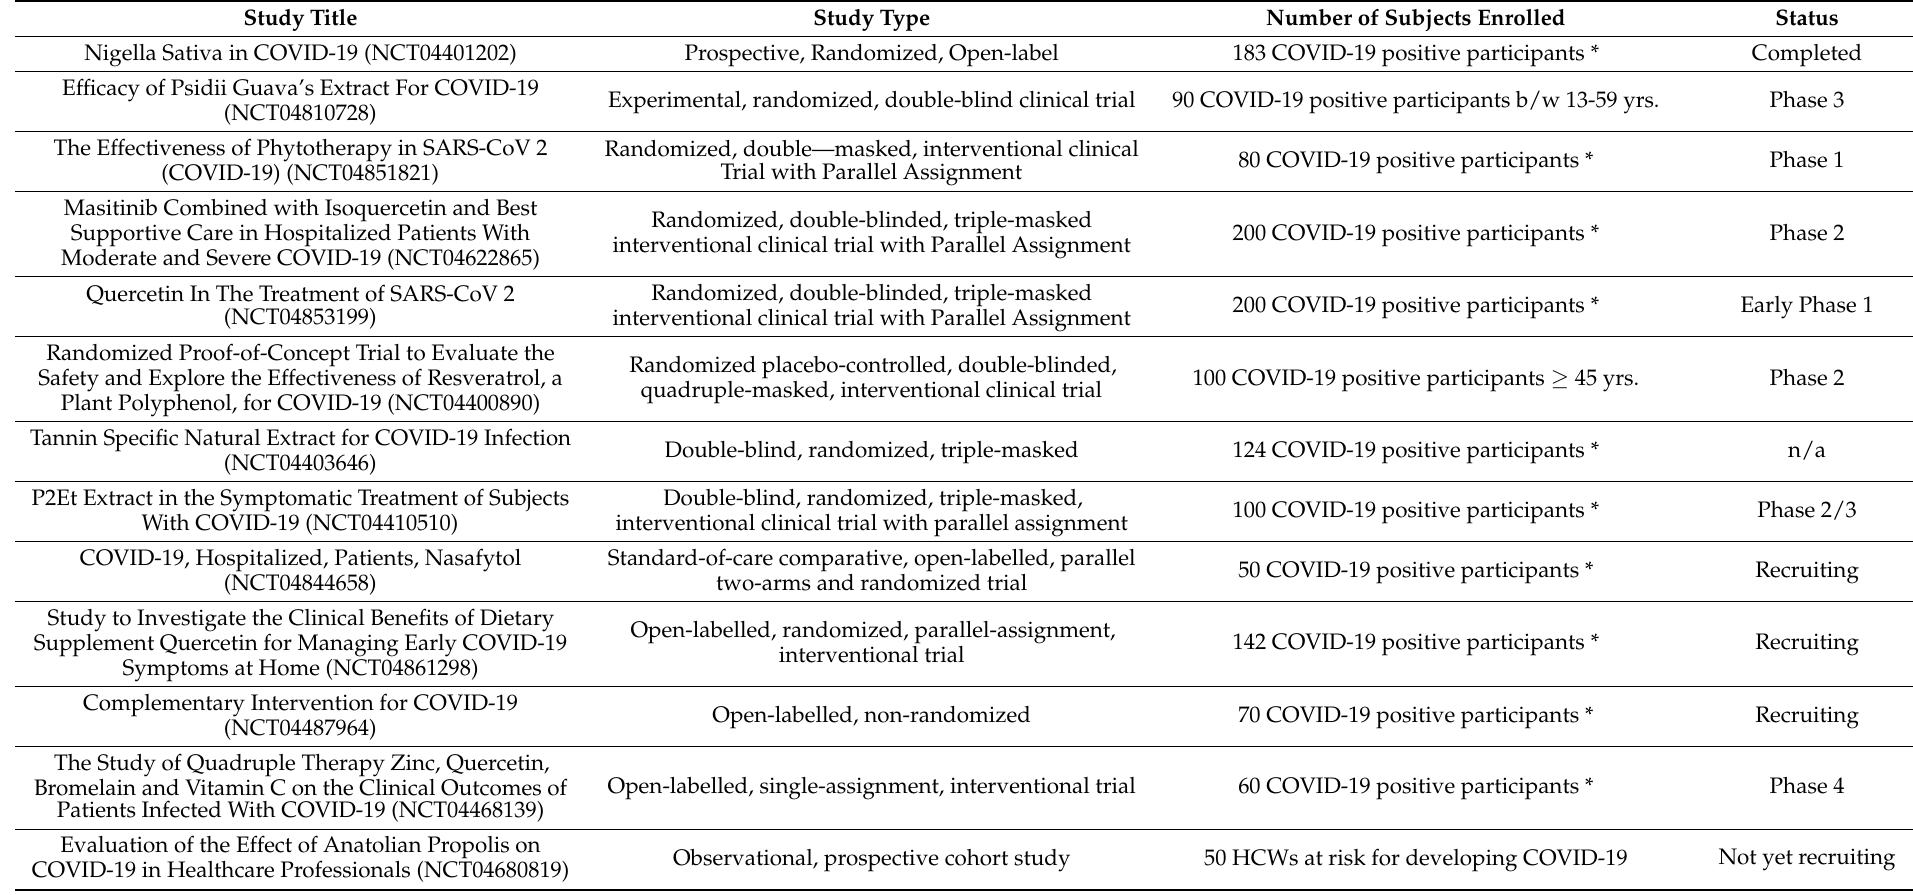
Table 5. Some flavonoids and their natural source extracts are currently in clinical trials on COVID-19 patients. Extracted on 17 August 2021 from https://clinicaltrials.gov, accessed on 3 June